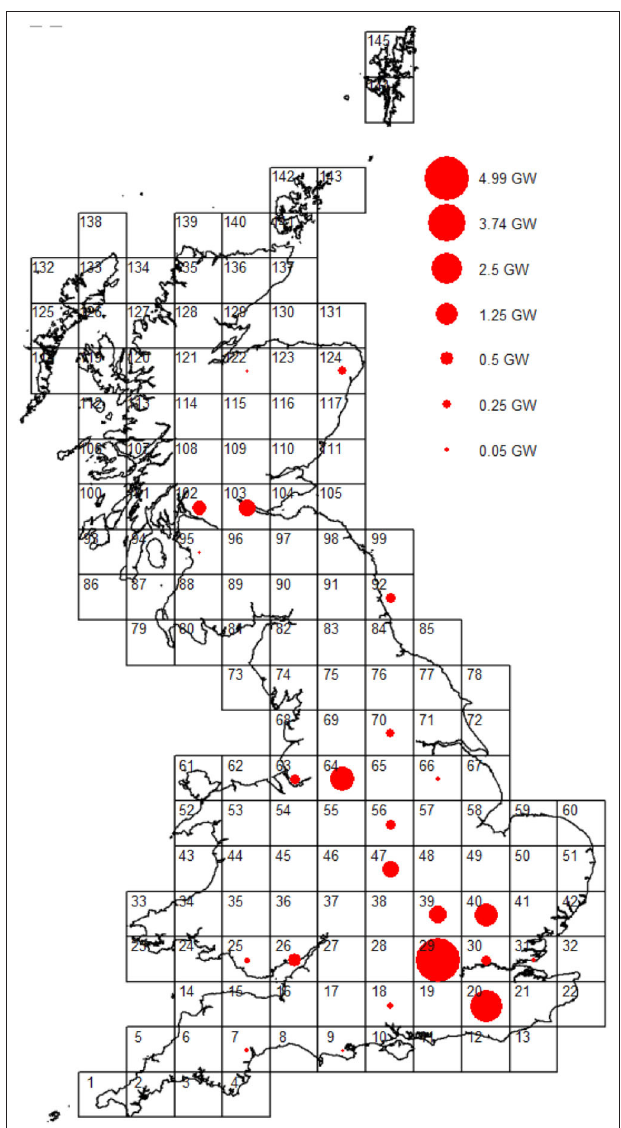
FIGURE 9 | Jet fuel demands for Great Britain at 50km